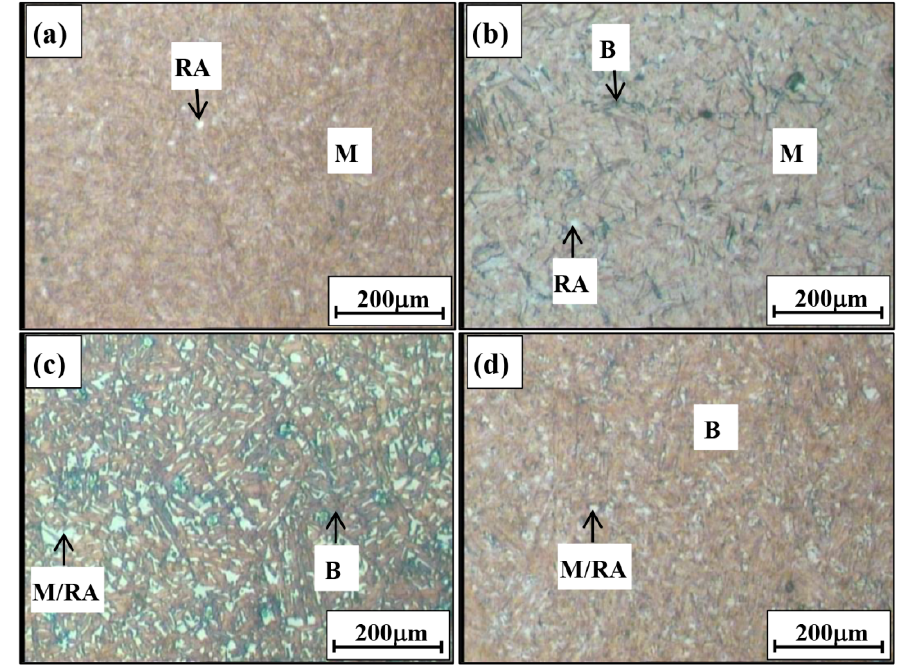
Figure 3. Light micrographs of Q&B samples isothermally treated at 350 °C molten salt bath for: ( a ) 5 s; ( b ) 30 s; ( c ) 200 s; and ( d ) 1 h after using LePera’s etching reagent. The symbols of B, M, RA and M / RA stand for bainite, martensite, retained austenite and martensite / retained austenite microconstituents, respectively.